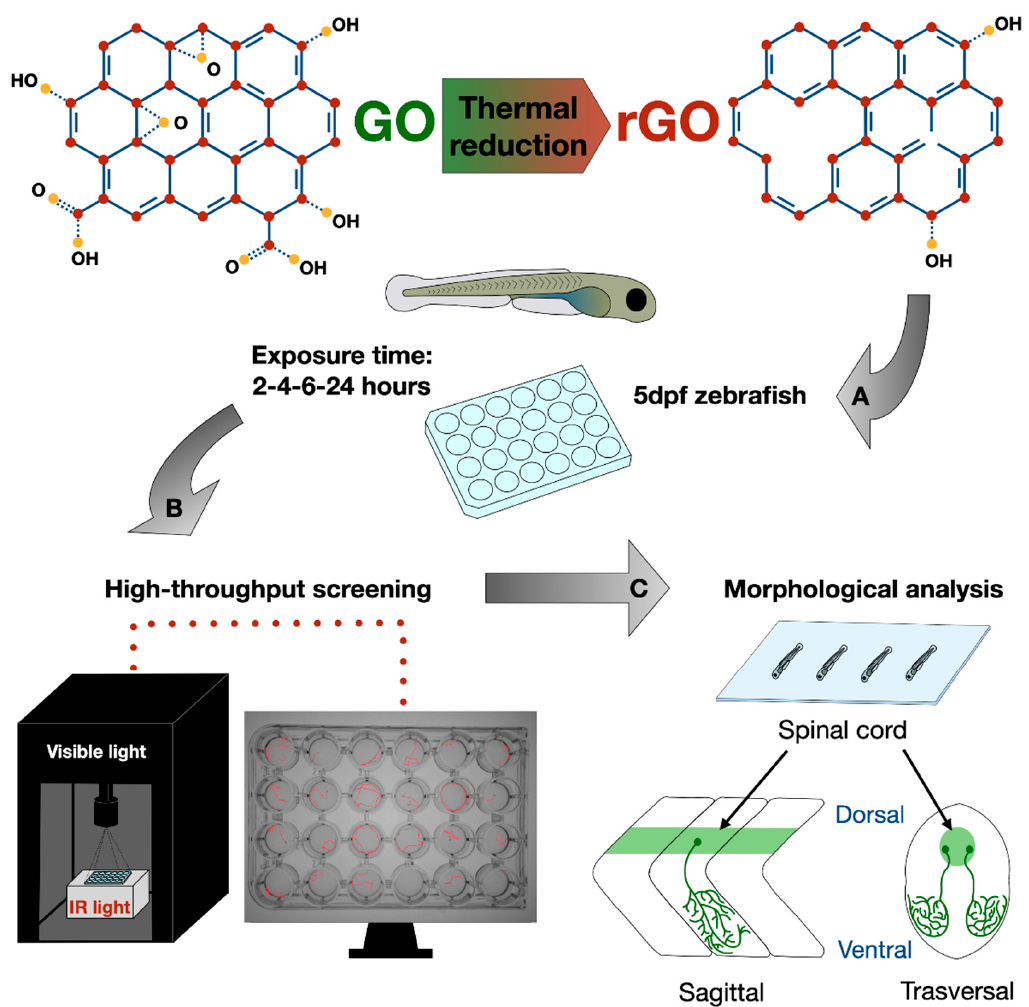
Figure 1. Experimental design of GRMs high throughput screening by using zebrafish larvae. ( A ) rGO was obtained by thermal reduction of GO at 650 and 1000 °C. Early-stage zebrafish (5 dpf) were treated chronically with GRMs and ( B ) used as behavioral model to investigate the effect of GRMs on the sensory-motor nervous system. ( C ) After behavioral experiments, animals were analyzed for anatomical traits and spinal cord characterization.